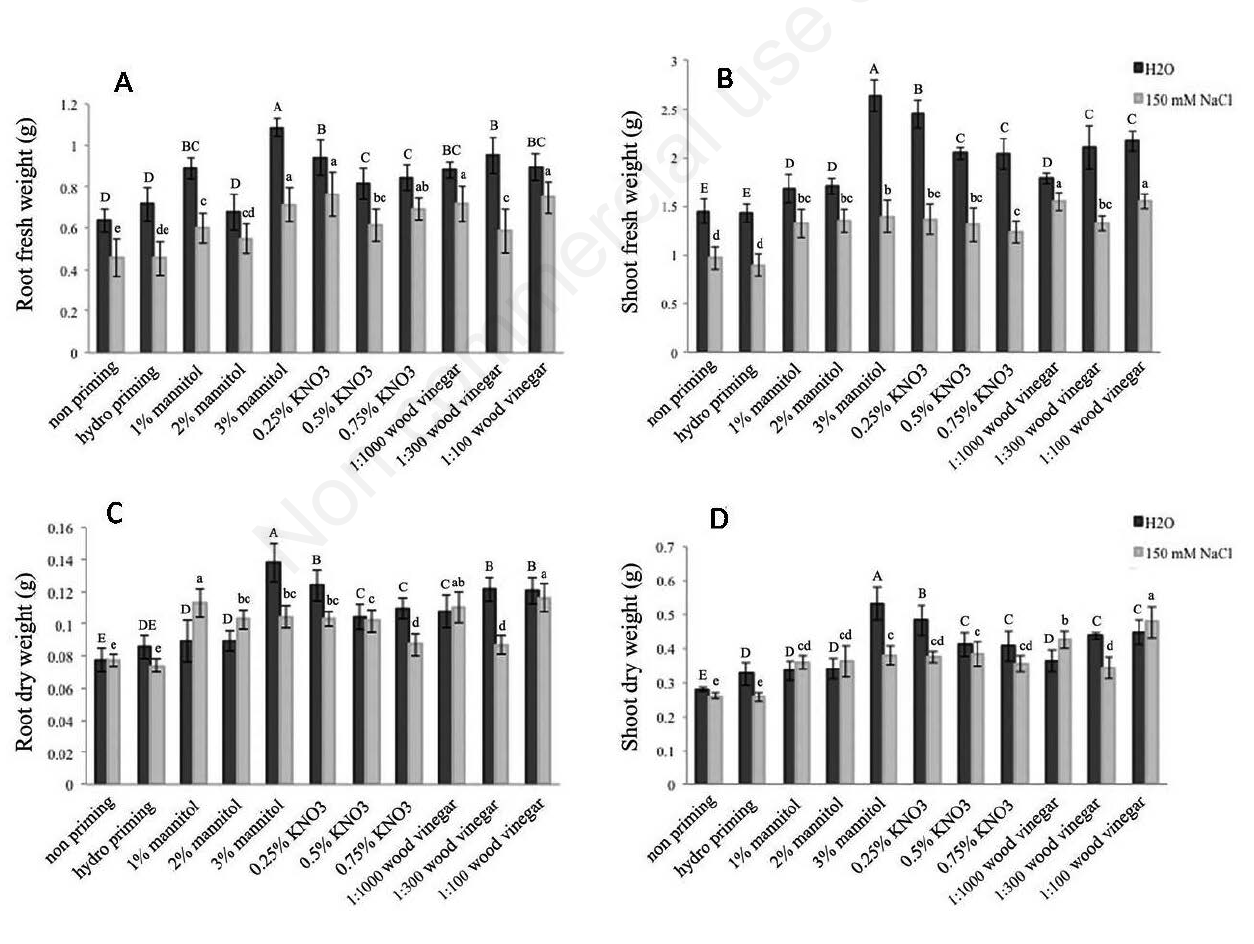
Figure 1. Root fresh weight (A), shoot fresh weight (B), root dry weight (C) and shoot dry weight (D) of 4-week-old rice plants raised from non-primed seeds and seeds primed with water, mannitol (1%, 2% and 3%), KNO3 (0.25%, 0.5% and 0.75%) and wood vinegar (1:1000, 1:300 and 1:100 dilutions) and grown under non-saline and saline condition (150 mM NaCl). Means sharing same alphabets (uppercase, non-saline condition; lowercase, saline condition) were not significantly different P ≤